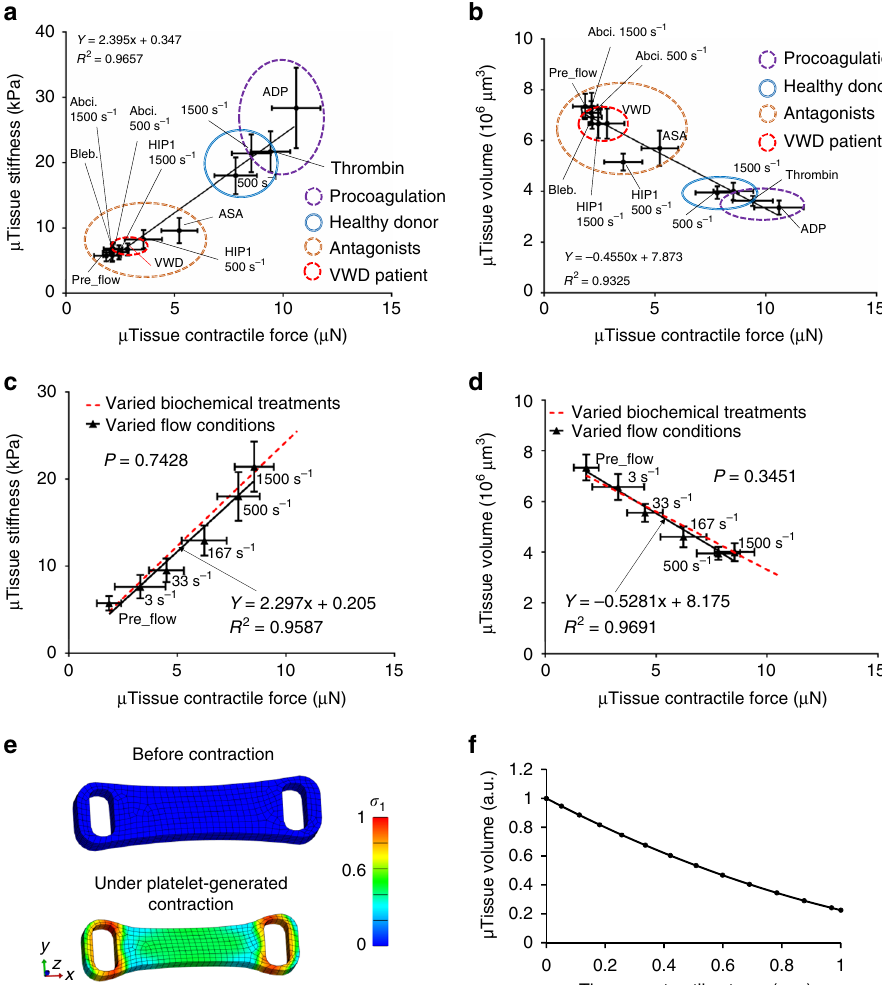
Fig. 6 Effects of biochemical treatment and shear fl ow on clot stiffening. Strong correlation between microclot stiffness and microclot contractile force ( a ) and between microclot volume and microclot contractile force ( b ) exists for various coagulation conditions under biochemical treatments. Abciximab (Abci.), Blebbistatin (Bleb.), VWD (VWD patient sample), acetylsalicyclic acid (ASA), anti-GpIb α antibody (HIP1). c , d Comparison of linear regressions between biochemical treatment condition and shear fl ow condition. Strong correlation between microclot mechanical properties also exists under varied shear fl ow (solid, black line). No signi fi cant difference was found for the regression slopes between biochemical treatment condition and shear fl ow condition. The signi fi cant difference of slopes and intercepts for two linear regressions was measured using a method equivalent to analysis of covariance (ANCOVA). Correlation between groups was analyzed using Pearson correlation coef fi cients. e Finite element model of the microclot before and under platelet-generated contraction. Simulated effective stress contour is plotted over undeformed and deformed model geometry. Active contraction of platelet population is represented by the contractility of every single element. Due to the geometrical restriction by two micropillars at both ends, microclot contraction causes volume shrinkage and the development of necking in the middle section, mimicking the microclot retraction process observed in the experiment. Color scale indicates normalized effective stress level. f Simulated decrease in microclot volume almost linearly correlates with increased contractile stress, recapitulating the experimental correlation between these two measurements. Data are presented as mean ± standard